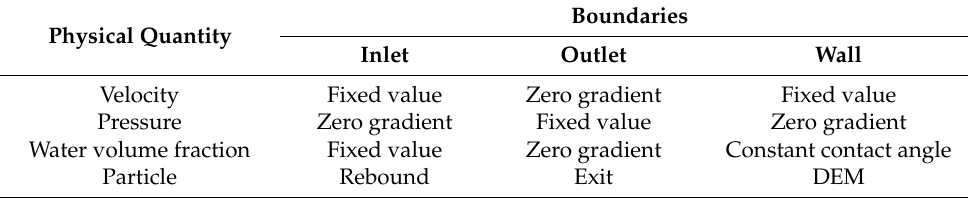
Table 3. Numerical boundary conditions.